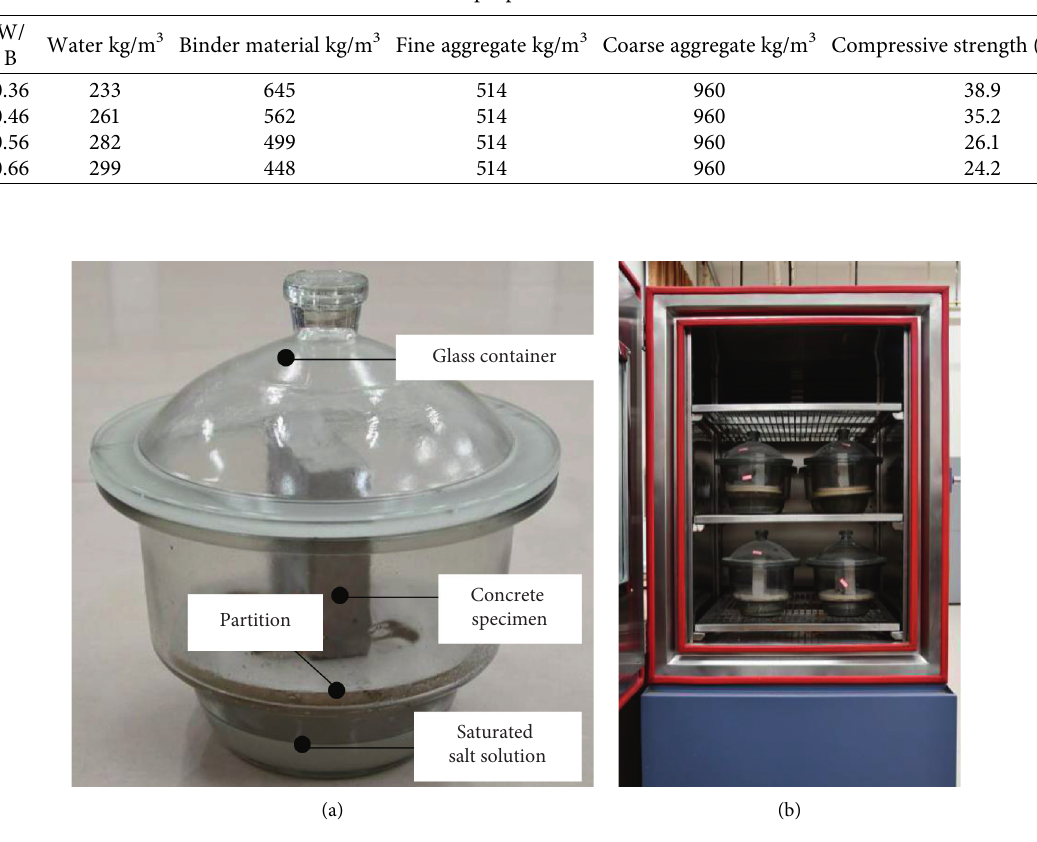
Figure 1: Isothermal absorption devices: (a) glass container and (b) constant temperature/humidity chamber.